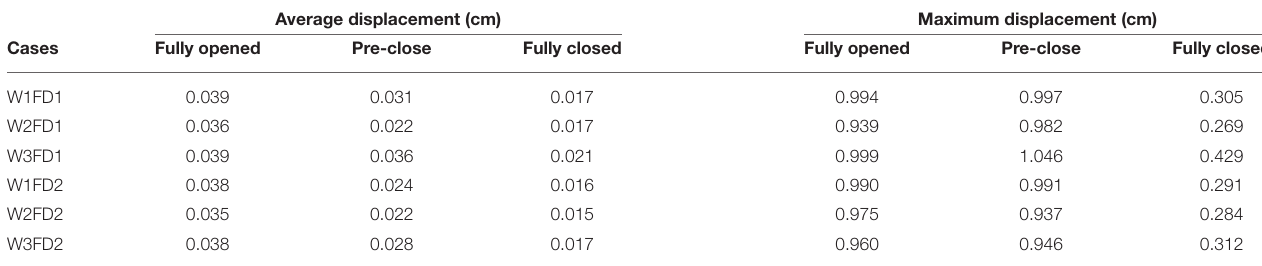
TABLE 2 | Average and maximum displacements of AV with six different cases.